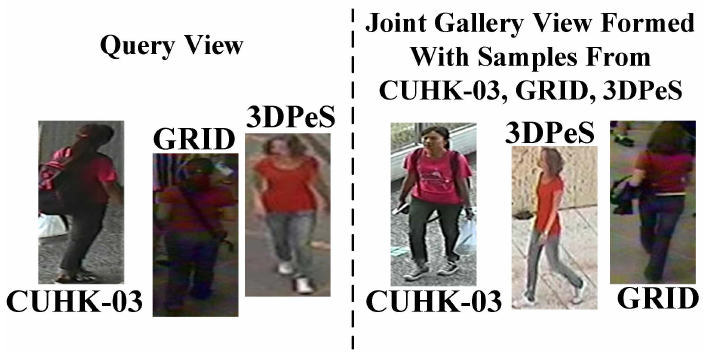
Figure 9. In Setting#2 the match for given Query image, the match for Query from GRID domain is found from the joint Gallery, where the Gallery contains images from all test domains, i.e., GRID, CUHK-03, and